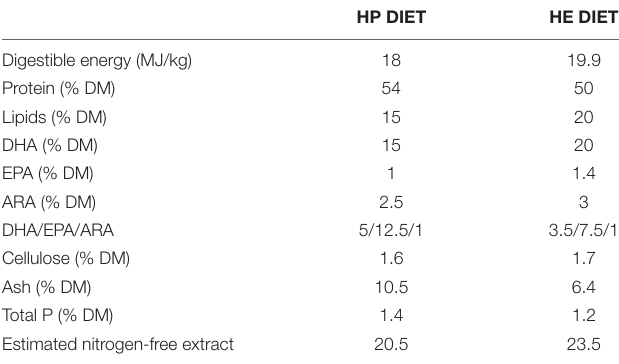
TABLE 1 | Chemical composition of the